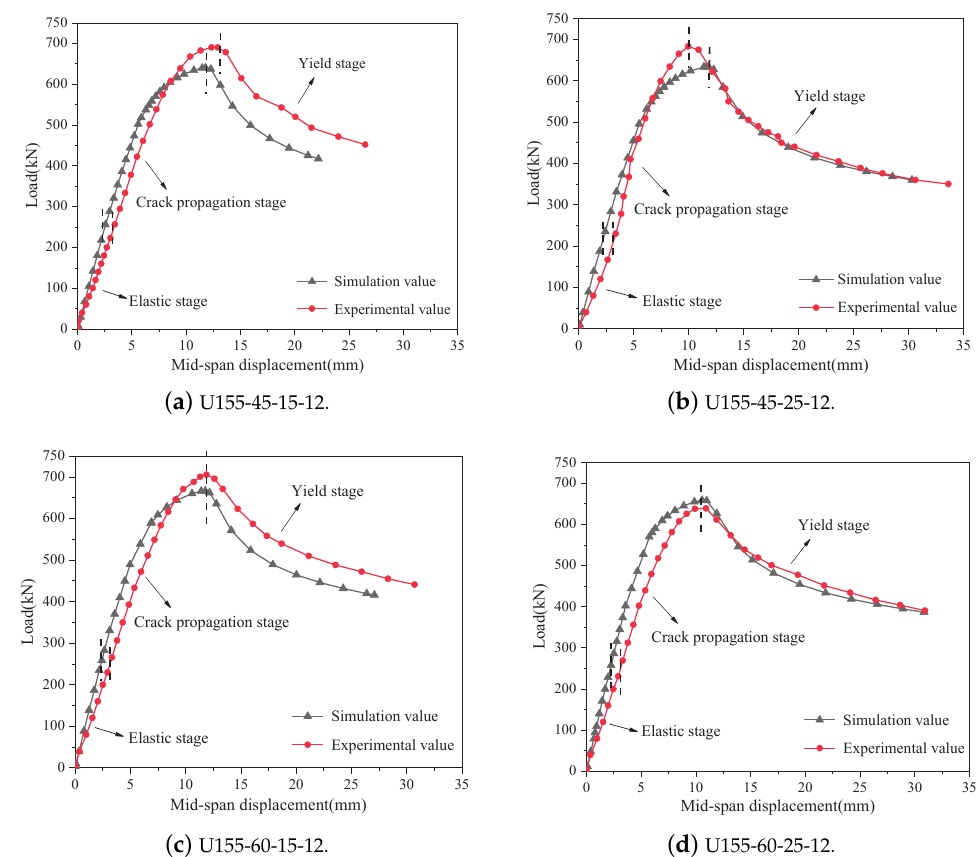
Figure 7. Load-mid-span displacement curve of composite beam.